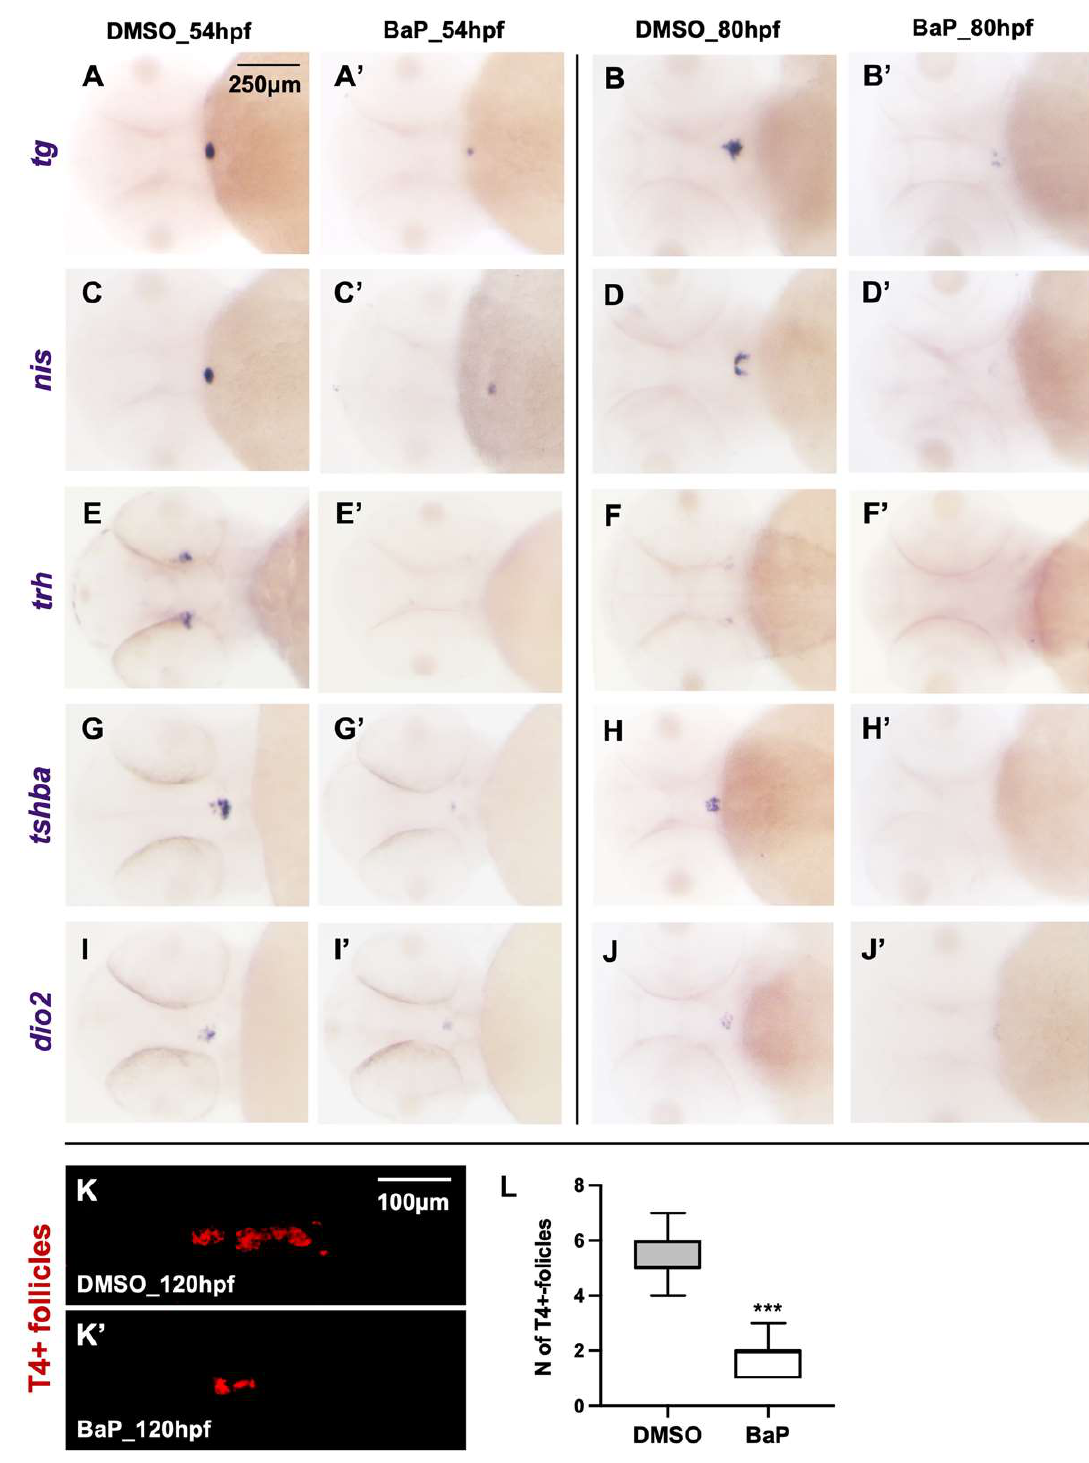
Figure 2. WISH and IF of thyroid function. ( A – J’ ) WISH of HPT axis markers in BaP treated embryos (50 nM) and controls (1.2 % DMSO) at 54 and 80 hpf. ( A – B’ and C – D’ ) tg and nis at the level of thyroid tissue; ( E – F’ ) trh expression in the hypothalamic region; ( G – H’ and I – J’ ) tshba and dio2 in the anterior pituitary. Each experiment was performed in triplicate using about 30 embryos/stage. Embryos were acquired in dorsal ( A – D’ ) or ventral ( E – J’ ) views, anterior to the left. ( K , K’ ) IF of T4 produced in thyroid follicles of DMSO and BaP treated larvae at 120 hpf. Thyroid regions were acquired mounting the heads in ventral view, anterior to the left. ( L ) Number of T4-positive follicles. Results are expressed by mean ± SD (*** p < 0.001).